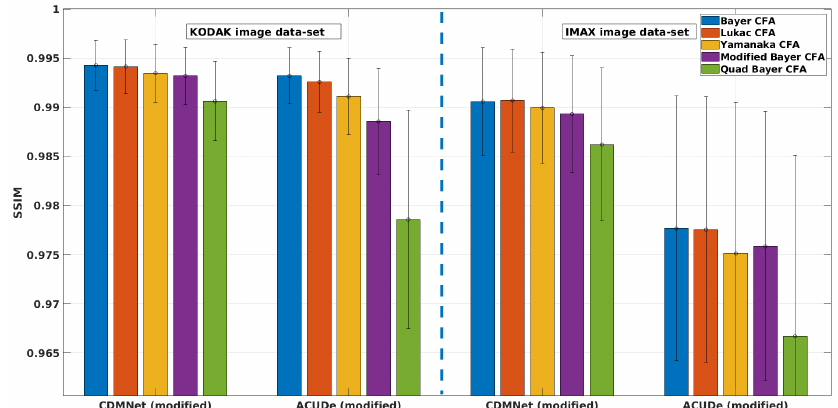
Figure 9. Average SSIM results with standard deviation of the mean: for the two modified generic algorithms (“CDMNet modified” and “ACUDe modified”), for the two data-sets (“KODAK” and “IMAX”), for five different Bayer-like patterns (Bayer, Lukac, Yamanaka, Modified Bayer and Quad